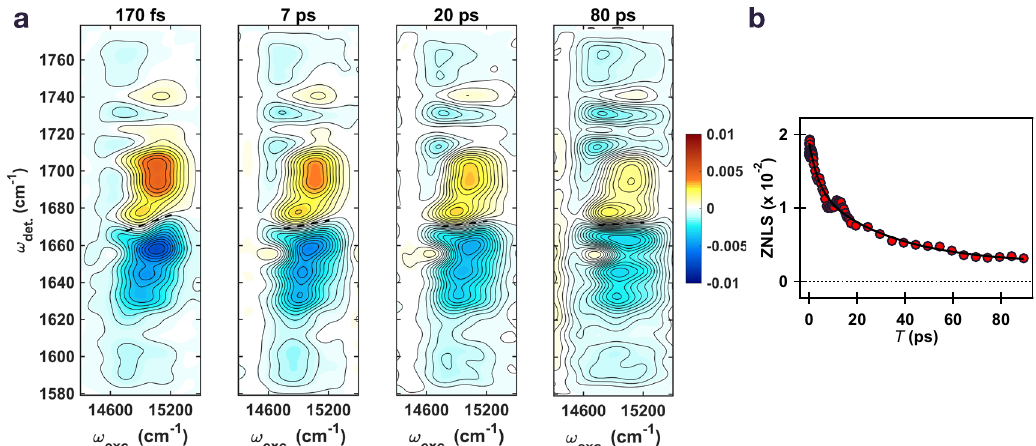
Fig. 5 2DEV spectral evolution and ZNLS dynamics of the PSII-RC. a 2DEV spectra of the PSII-RC at different waiting times. Zero node line slope (ZNLS), obtained by a linear fi t of the zero signal intensity distribution along the excitation axis, is depicted in the spectra as a dotted line. Contour levels are drawn in 5% intervals. b ZNLS dynamics of the PSII-RC. Red dots indicate the ZNLS value at each waiting time and the black curve shows the fi t result of double exponential functions (and an offset) with time constants of 3.8 ± 0.9 and 33 ± 9